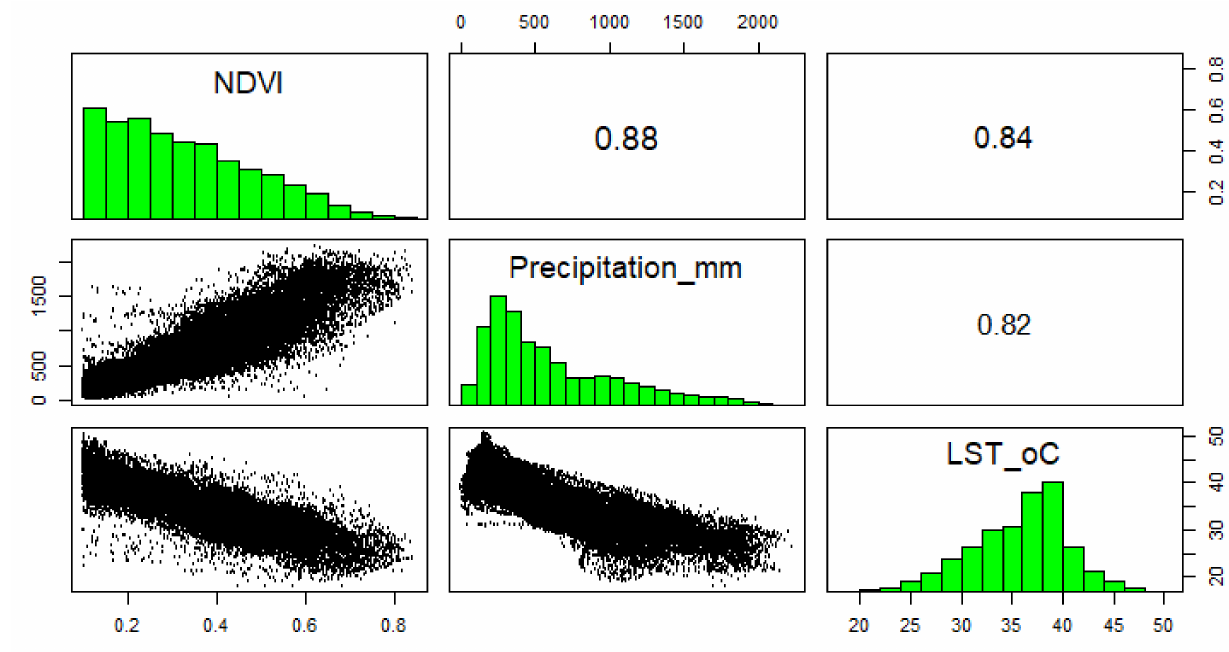
Figure 5. Pearson correlation coefficient (PCC) based on mean annual values of NDVI, precipitation, and LST during 2000–2019 in the Horn of